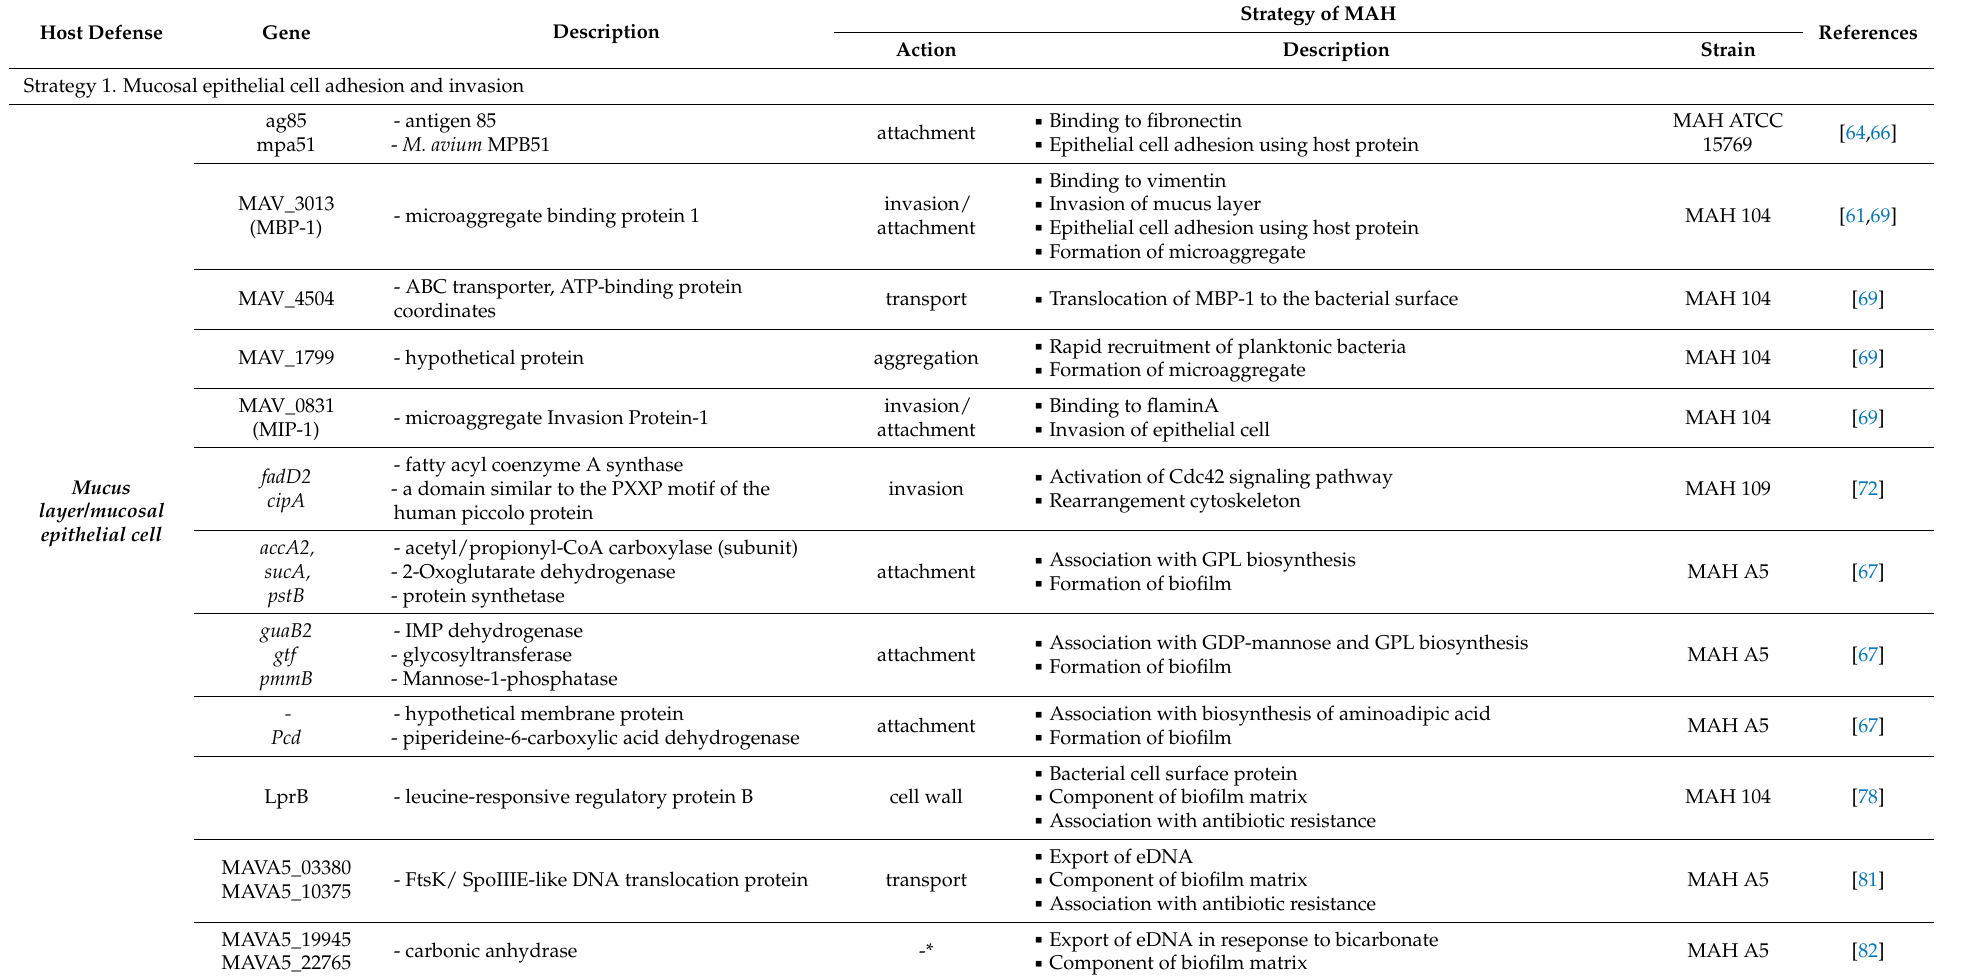
Table 2. Virulence-associated genes of Mycobacterium avium subsp. hominissuis during the pathogenesis.